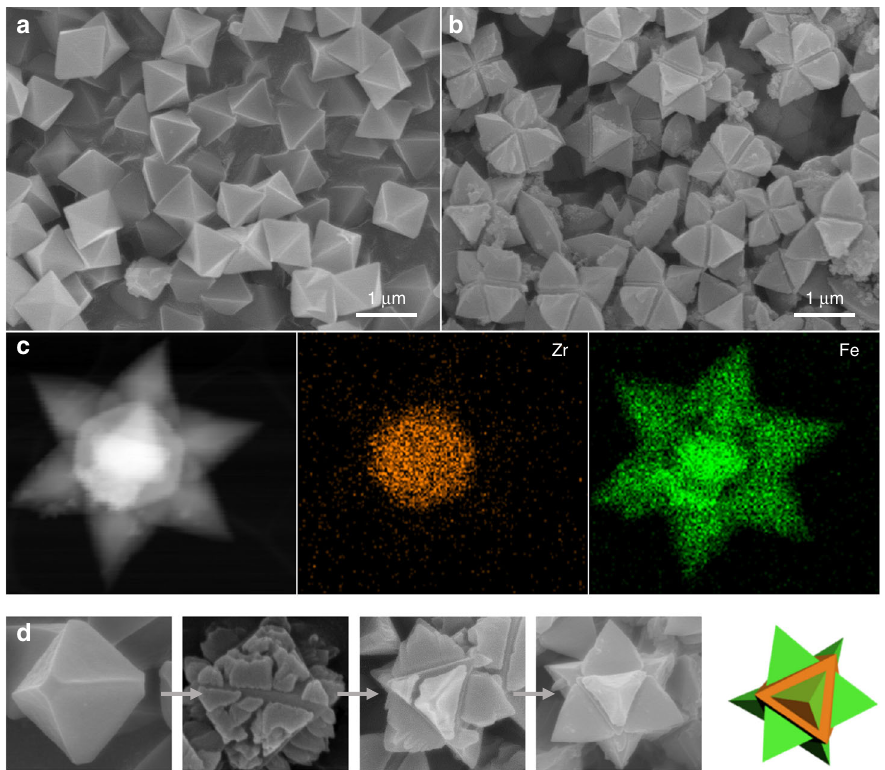
Fig. 5 Facet-oriented formation of UiO-66@MIL-88B(Fe) from the octahedral UiO-66 crystals. a SEM image of octahedral UiO-66 crystals. b SEM image of octahedral UiO-66@MIL-88B(Fe) crystals. c STEM image of UiO-66@MIL-88B(Fe) and corresponding mapping of two elements, Zr(orange) and Fe (green), based on EDS. d Growth process of single crystalline star-shaped UiO-66@MIL-88B(Fe) and schematic image of star-shaped UiO-66@MIL-88B (Fe) single